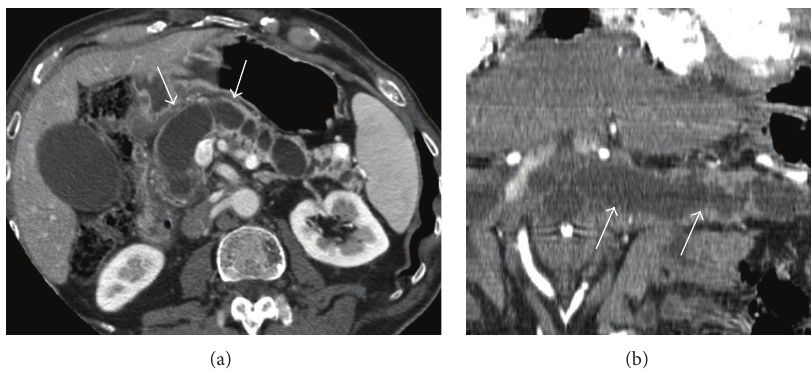
Figure 1: CT postcontrast examination in a patient who was suffering from jaundice and abdominal pain: axial images after contrast administration (a) and curved-MPR images (b). White arrows in (a) and (b) show a marked dilatation of the entire main pancreatic duct, from the head to the tail of the gland, associated with subtotal parenchymal atrophy. No dilatation of secondary branches was observed, and radiological diagnosis of MD-IPMN was formulated. The high degree of main pancreatic duct dilatation ( > 1cm) was considered as high- risk stigmata and required surgical treatment. In addition, white arrows show mild wall enhancement. Final diagnosis of invasive cancer (adenocarcinoma) in IPMN was reported.